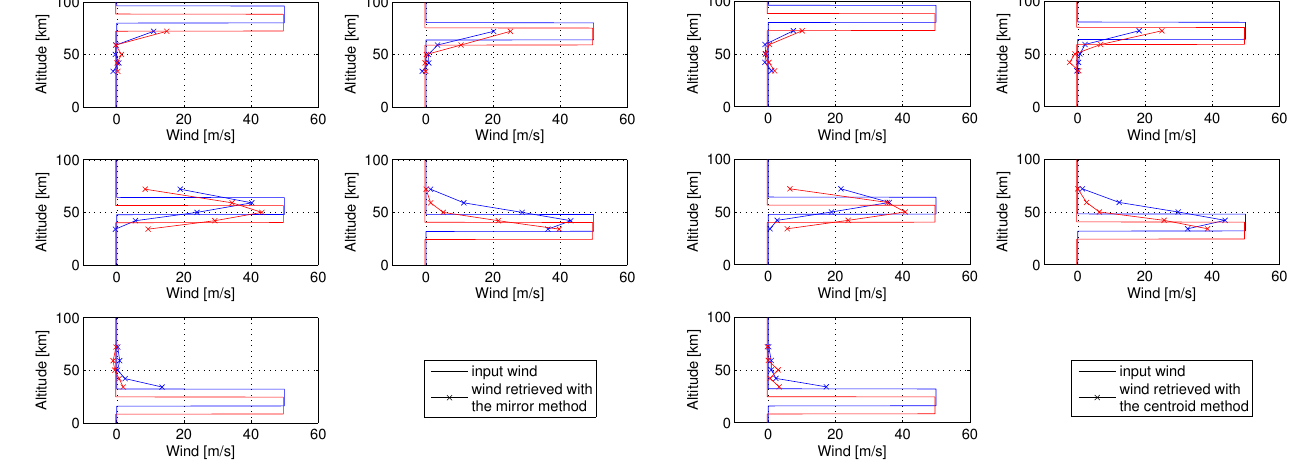
Fig. 9. Ten different input wind profiles with the corresponding re- trieved winds for the mirror method. The input wind profile and the associated retrieved winds are plotted in the same colour. The mark- ers for the retrieved wind are positioned at the central altitudes of the WIRA levels.